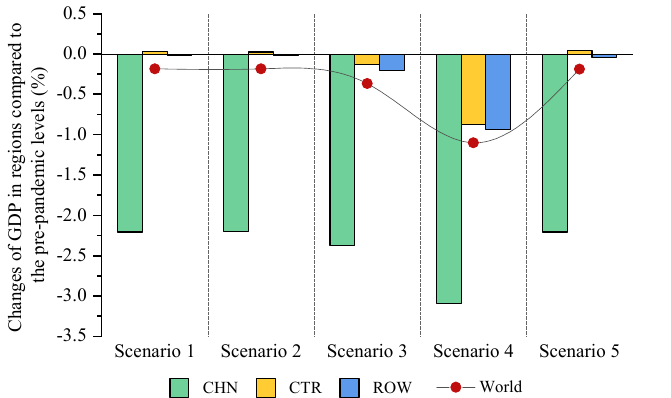
Figure 2. The impact of the COVID-19 outbreak in China on GDP in trade regions in the context of trade protectionism.